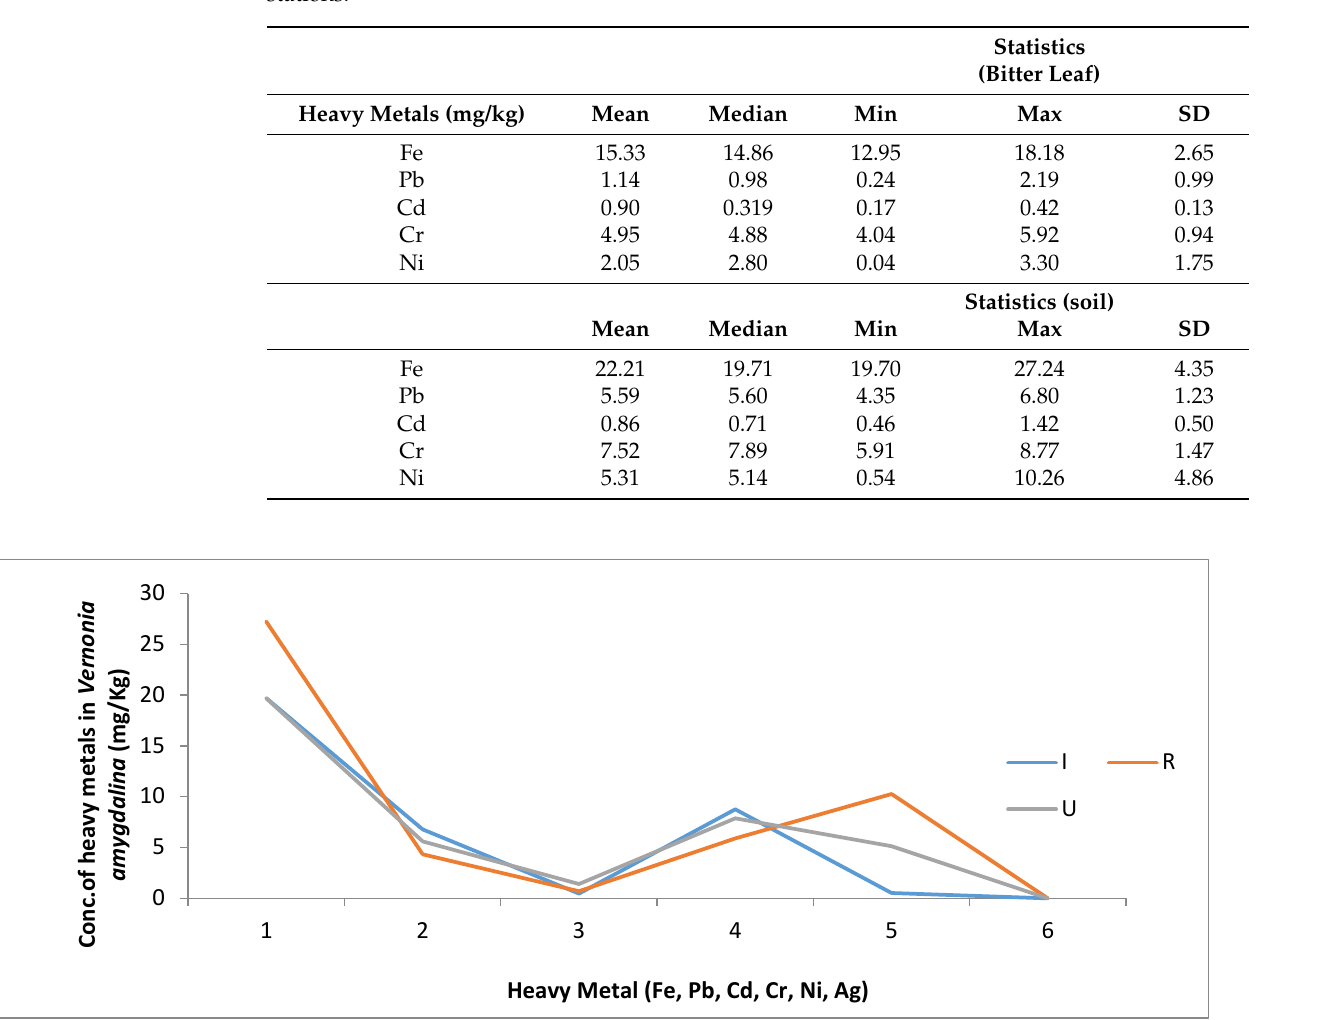
Figure 6. Spatial variation of heavy metals in Vernonia amygdalina.